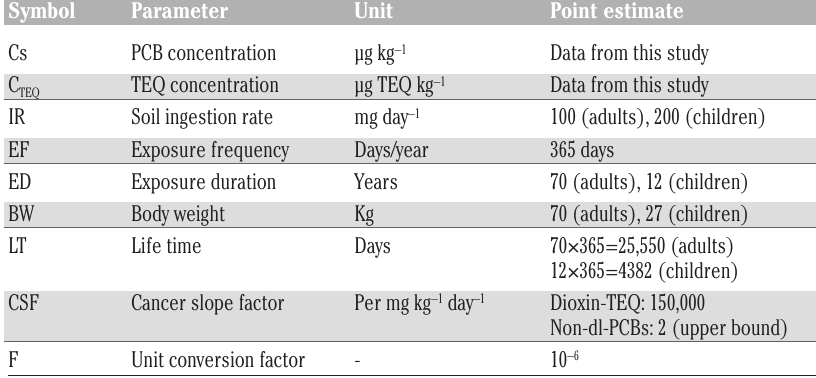
Table 1. Summary of input parameters used in calculations for health risk